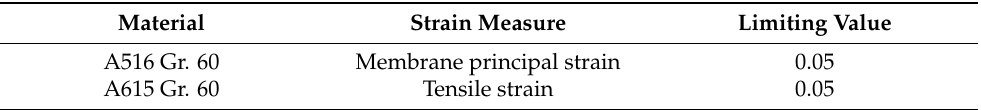
Table 5. Ductile failure strain